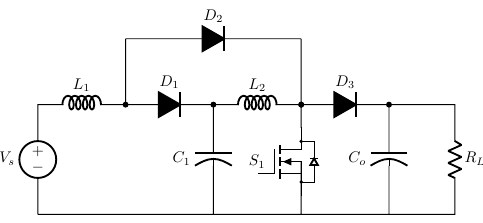
Figure 4. General Setup of Quadratic Boost Converter